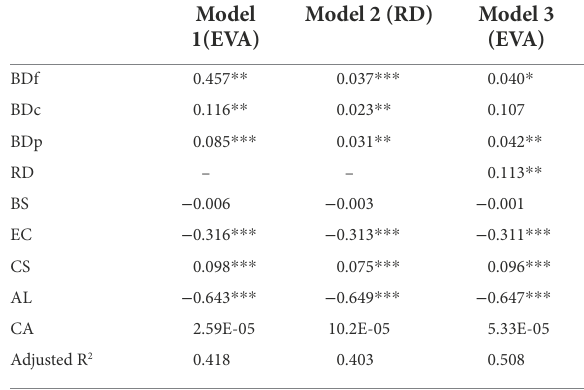
TABLE 6 Multicollinearity test. TABLE 7 Results of the three-step mediating effect